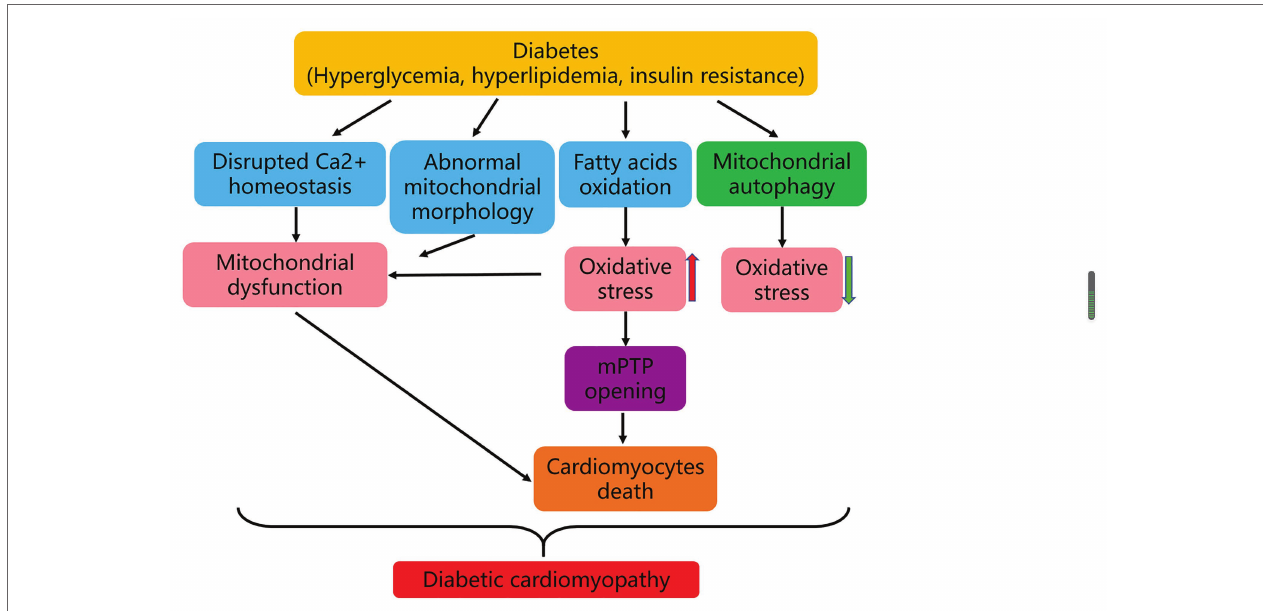
FIGURE 1 | Mechanisms of DCM. In diabetes, hyperglycemia, hyperlipidemia, and insulin resistance result in disrupted Ca 2+ homeostasis, abnormal mitochondrial morphology, and enhanced fatty acids oxidation. The latter changes further lead to mitochondrial dysfunction and strengthened oxidative stress, which induce cardiomyocytes death and eventually cause DCM. In the development of DCM, mitophagy may play a protective